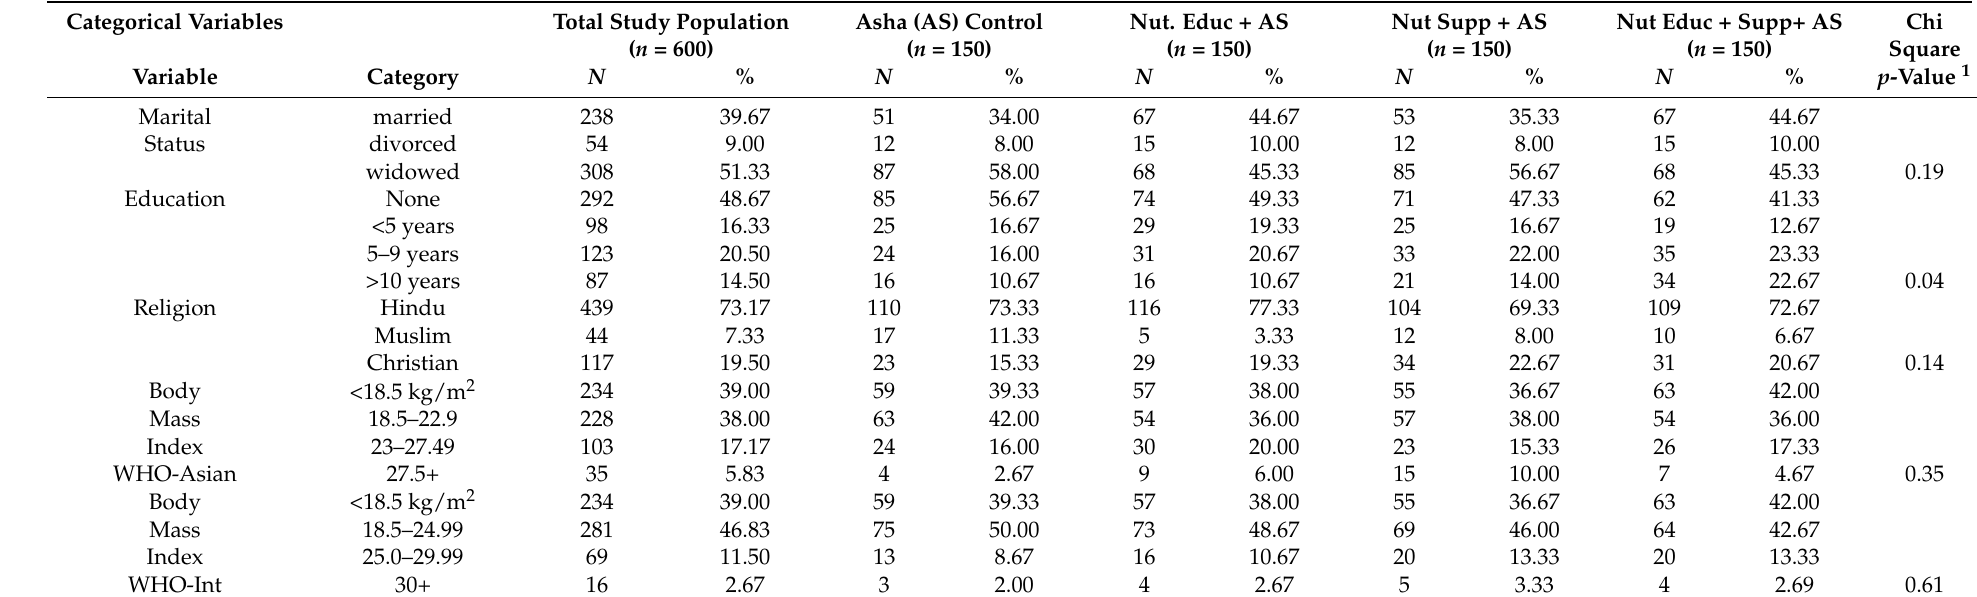
Table 2. Description at Baseline of the Total Population and Population According to Group